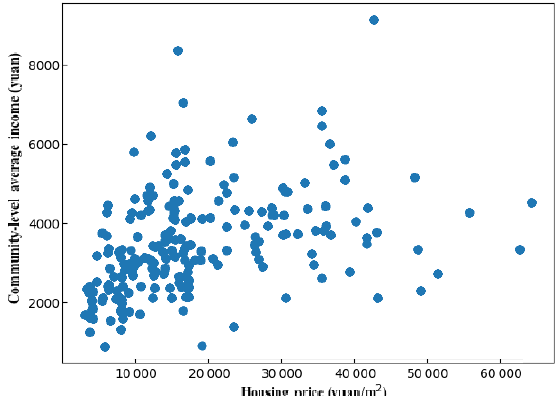
Fig. 3 Relationship between housing price and community- level average personal income in